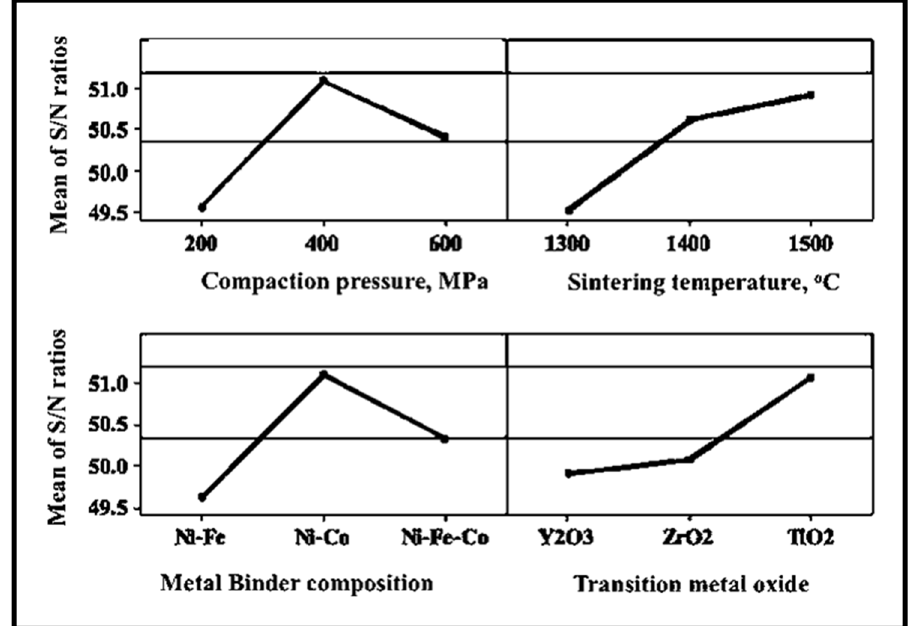
Figure 7. Mean of S/N ratios for hardness of samples versus levels of input parameters. Figure 7. Mean of S / N ratios for hardness of samples versus levels of input